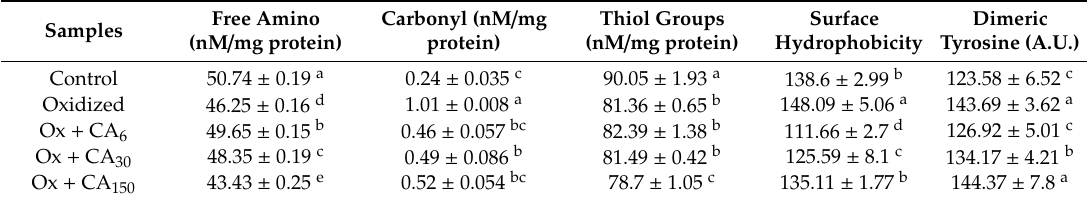
Table 1. Changes in physicochemical and gel properties of oxidized myofibrillar protein (MP) with chlorogenic acid (CA).